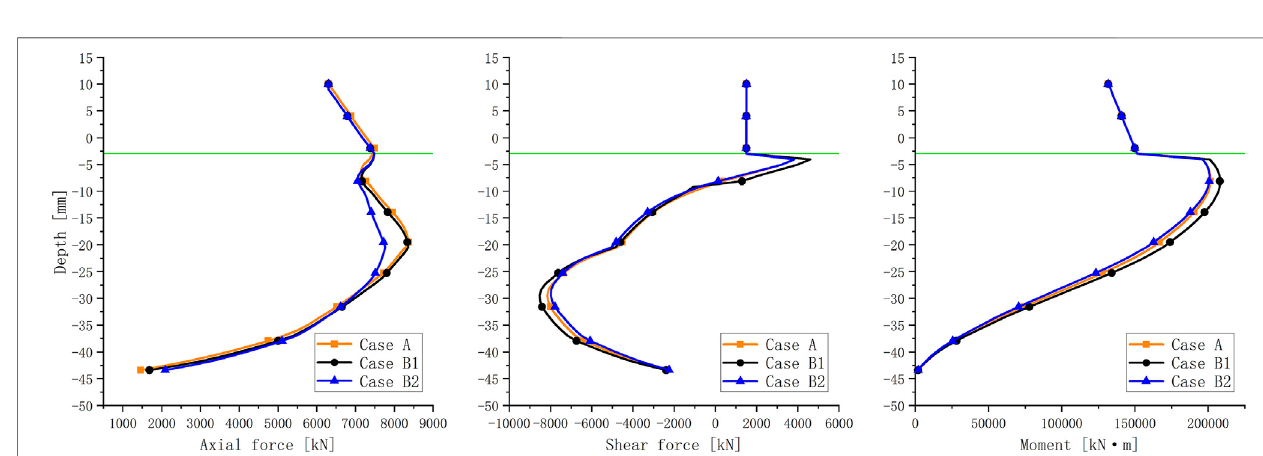
Frontiers in Physics |